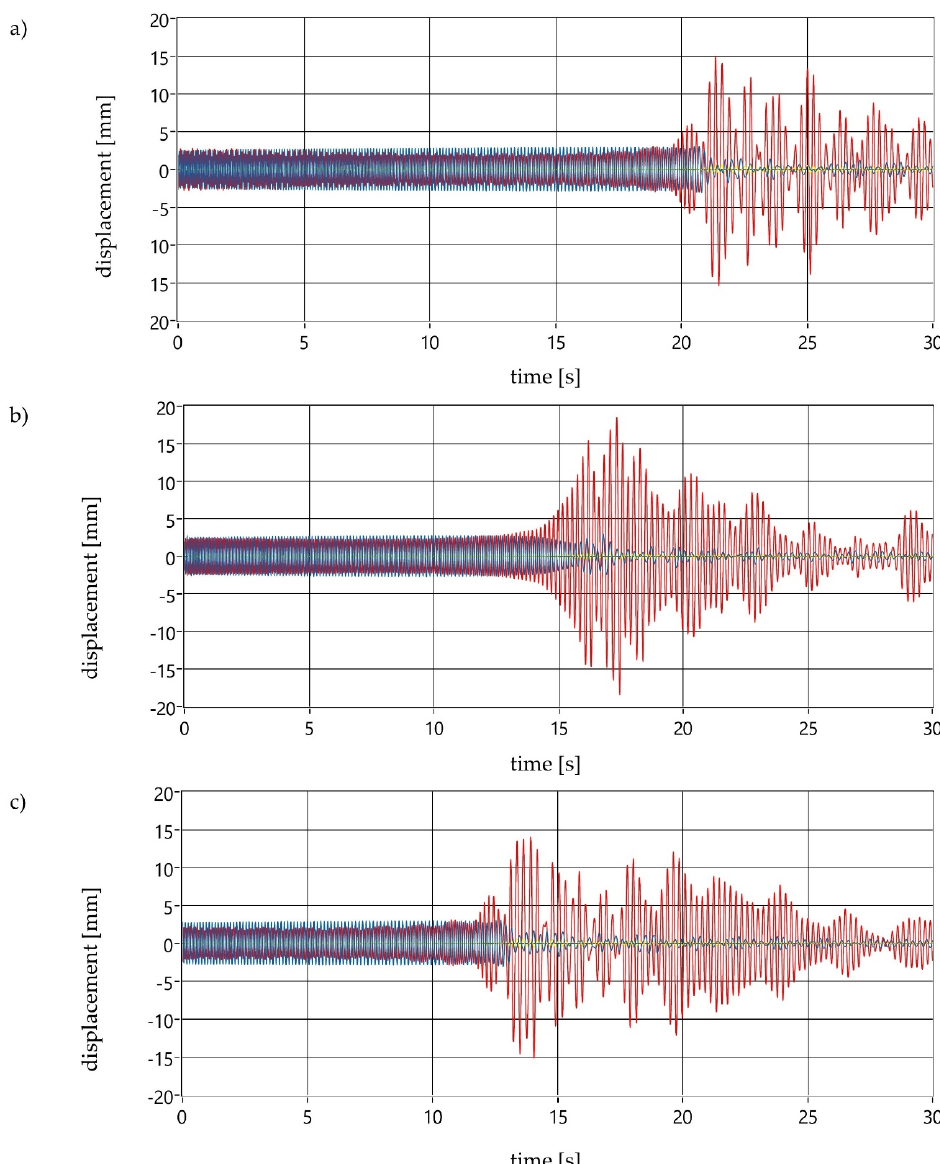
Figure 12. Time course of the new drive’s vibration amplitude measured at point 1L versus time (y direction-red, x-blue, z-green) during braking for the rated frequency: ( a ) f = 13.2 Hz; ( b ) f = 16.5 Hz; ( c ) f = 19.8 Hz.